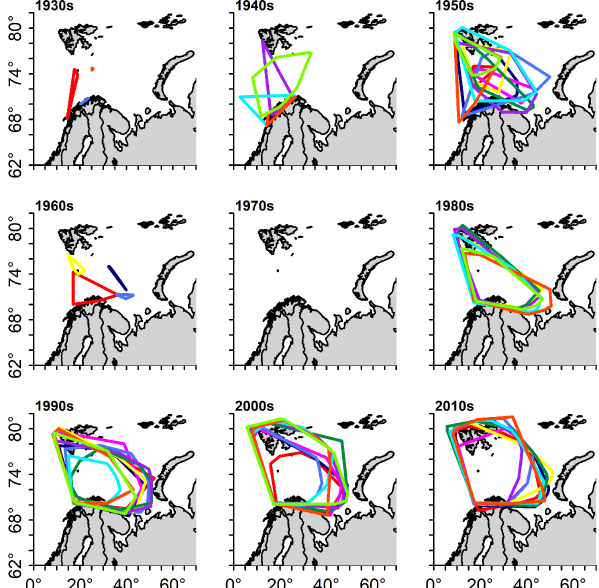
Figure 3. Extent of the sampling coverage in each decade. Red: year 0, e.g. 1940; dark blue: year 1, e.g. 1941; pink: year 2, e.g. 1942; navy blue: year 3, e.g. 1943; yellow: year 4, e.g. 1944; dark green: year 5, e.g. 1945; purple: year 6, e.g. 1946; pale blue: year 7, e.g. 1947; orange: year 8, e.g. 1948; pale green: year 9, e.g.